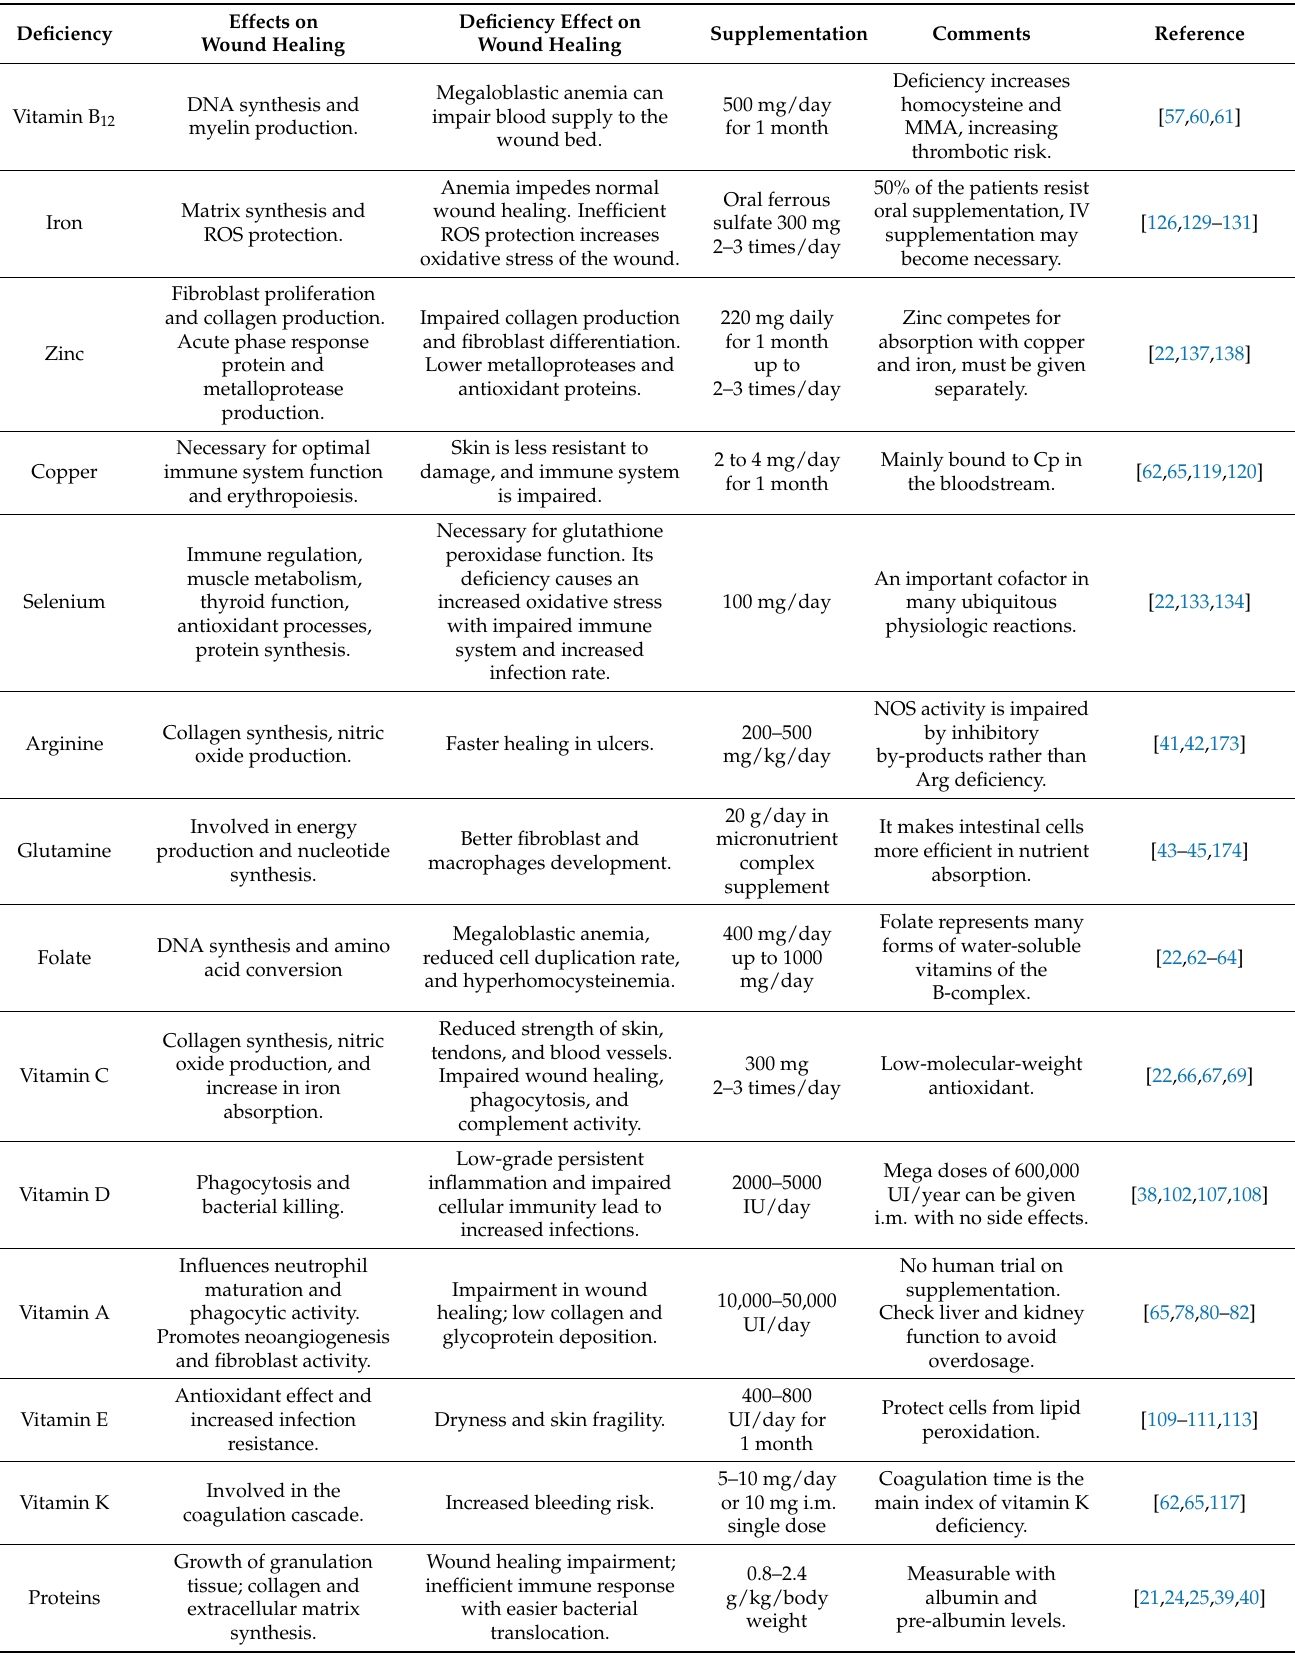
Table 1. Most common nutrient deficiencies in post-bariatric patients and their effects on health and wound